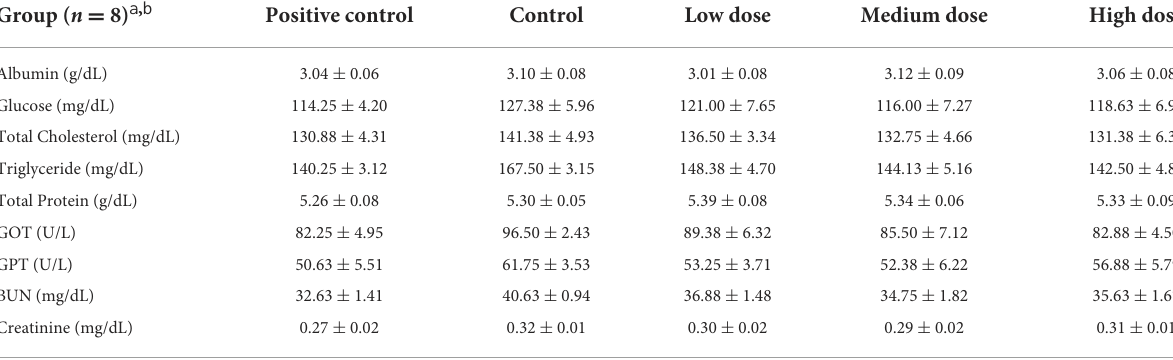
TABLE 3 Investigation of biochemical analysis of blood profiles in mice treated with combined extracts. Group ( n = 8) a ,